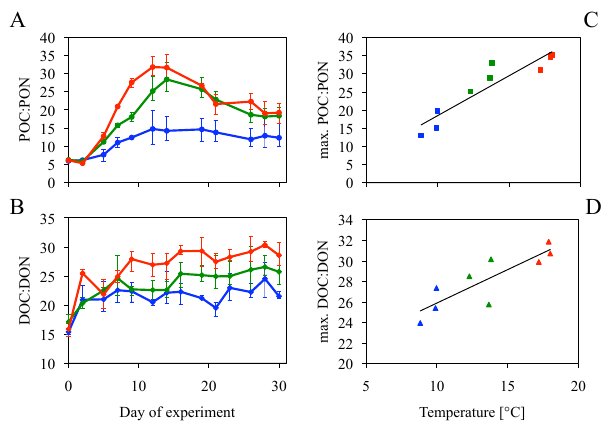
Fig. 5. Temporal development of C:N in (A) particulate and (B) dissolved organic matter. Maximum C:N of (C) particulate and (D) dissolved organic matter as a function of temperature. Style and color-coding follow that of Fig. 3. Solid lines denote lin- ear regressions ( n = 9; POC:PON max : R 2 = 0 . 86, p < 0 .